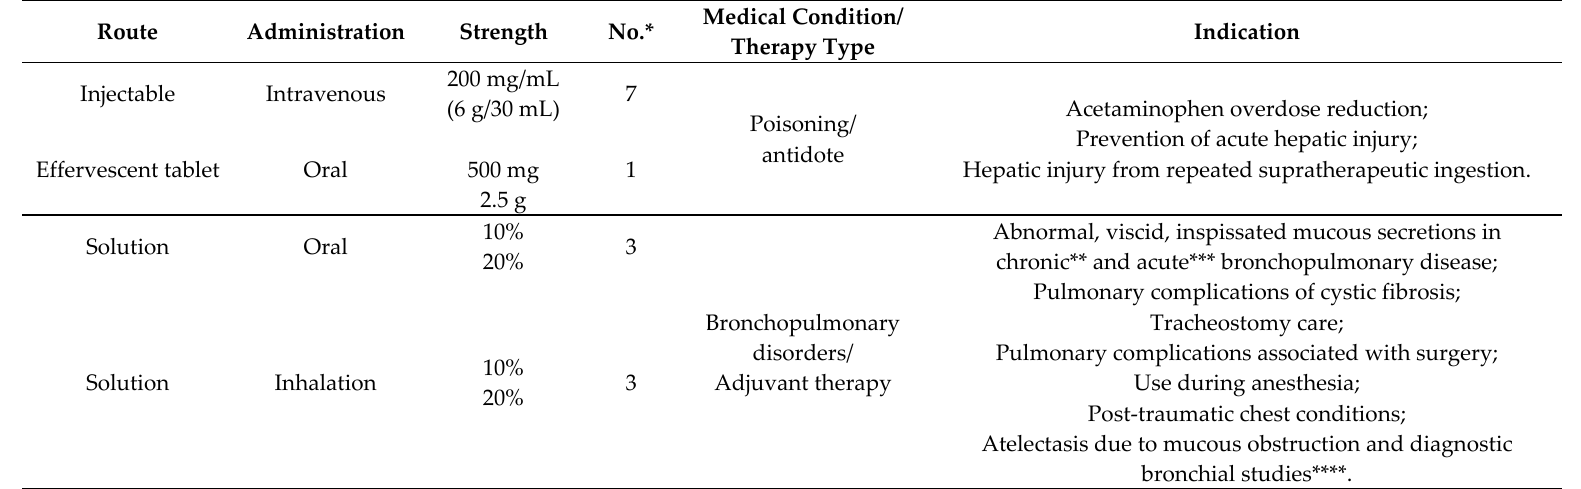
Table 1. Overview of Food and Drug Administration FDA-approved N-acetyl-cysteine (NAC) drugs and their indications.